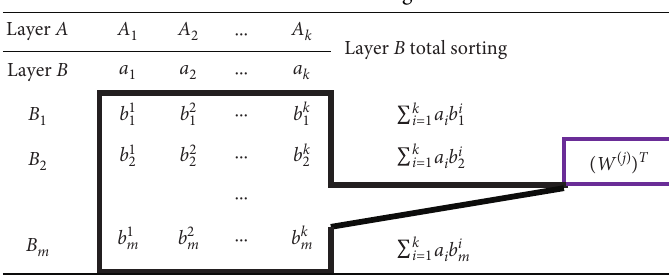
Table 3: Total sorting